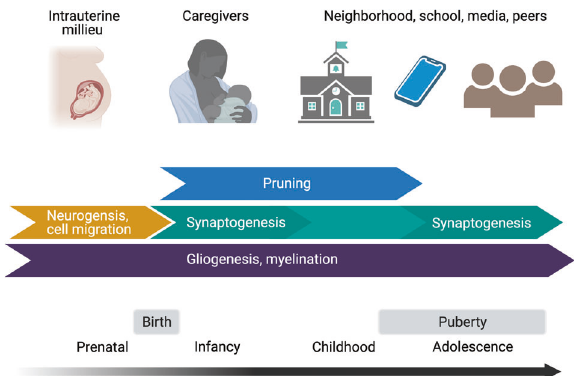
Fig. 1 Primary sources of environmental input and mechanisms of neuroplasticity across development. Whether and how adver- sity disrupts or calibrates biological systems implicated in depres- sion depends largely on the developmental stage of the organism. Primary sources of environmental input and mechanisms of neuroplasticity change across the period spanning gestation to adolescence. Maternal physiological signals transmitted to the intrauterine environment in fl uence neurogenesis and cell migra- tion. As children mature, dominant sources of environmental input expand, coinciding with ongoing changes in synaptic formation and remodeling, and with changes in gliogenesis and myelination. Primary sources of expected environmental input can also serve as sources of adversity that in fl uence the neurodevelopmental processes taking place in that period. Figure created with